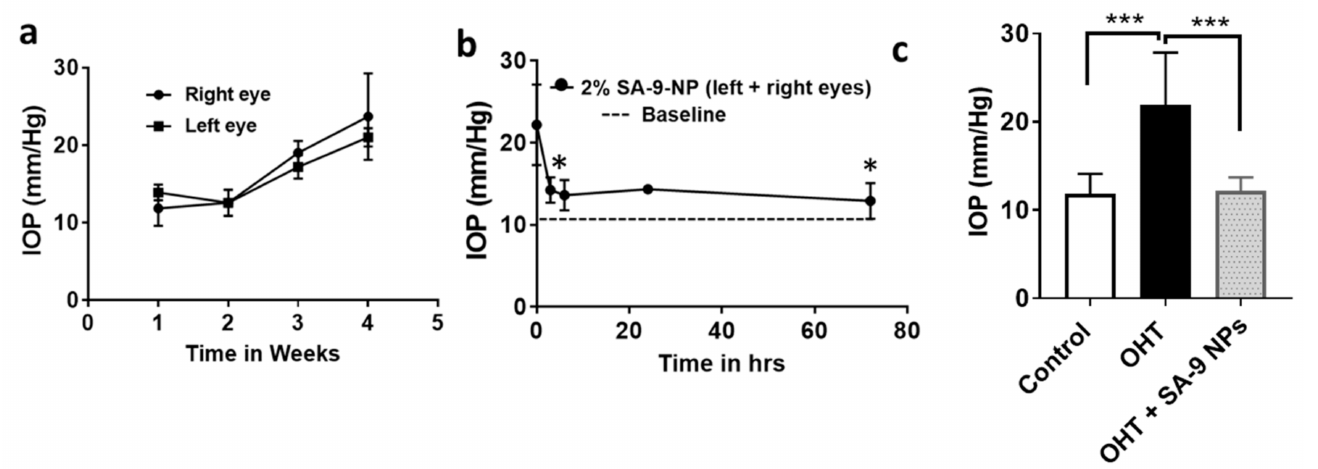
Figure 9. ( a ) IOP of both left and right eyes of the mice were elevated after periocular injection of DEX-Ac (10 mg/mL) once every week for 4 weeks. ( b ) IOP lowering activity of 2% SA-9 NPs in both OHT eyes of C57Bl/6J mouse. Treatment with 2% SA-9 NPs eye drop after 4 weeks of Dex-Ac injection significantly decreased the IOP in both eyes and bring to basal level. The effect lasted up to 72 h. ( c ) There is significant increase in IOP after periocular injection of DEX-Ac once a week for 4 weeks in mouse eyes, here referred as OHT group. Treatment with SA-9 NPs significantly decreased ( − 61%) the IOP at 3 h post dose. * p < 0.05, *** p < 0.005, respectively for 3 h vs. OHT groups. n = 6–8